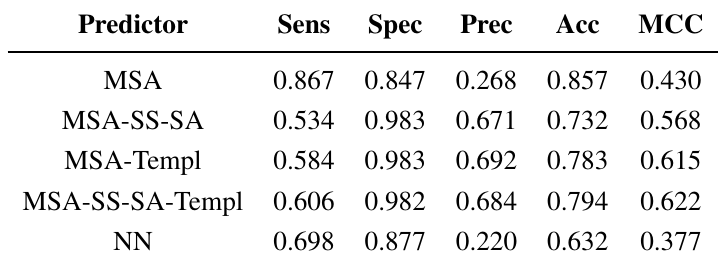
Table 1. Result of Sensitivity (Sens), Specificity (Spec) , precision (Prec), accuracy (Acc) and Matthews’ correlation coefficient (MCC) on training sets for all of our